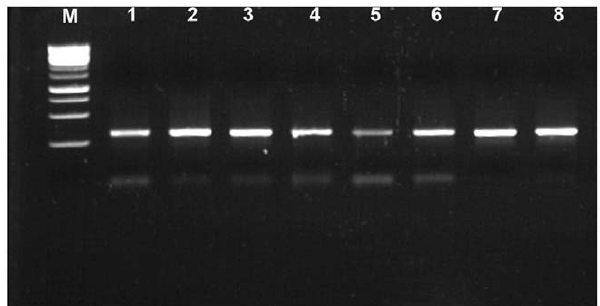
Figure 3. Neutral agarose gel electrophoresis of reamplified assorted DGGE-resolved products from Figure 2. Lane M: DNA 1- Kb marker, lanes 1–8 correspond to the bands letters (A–H) in Figure